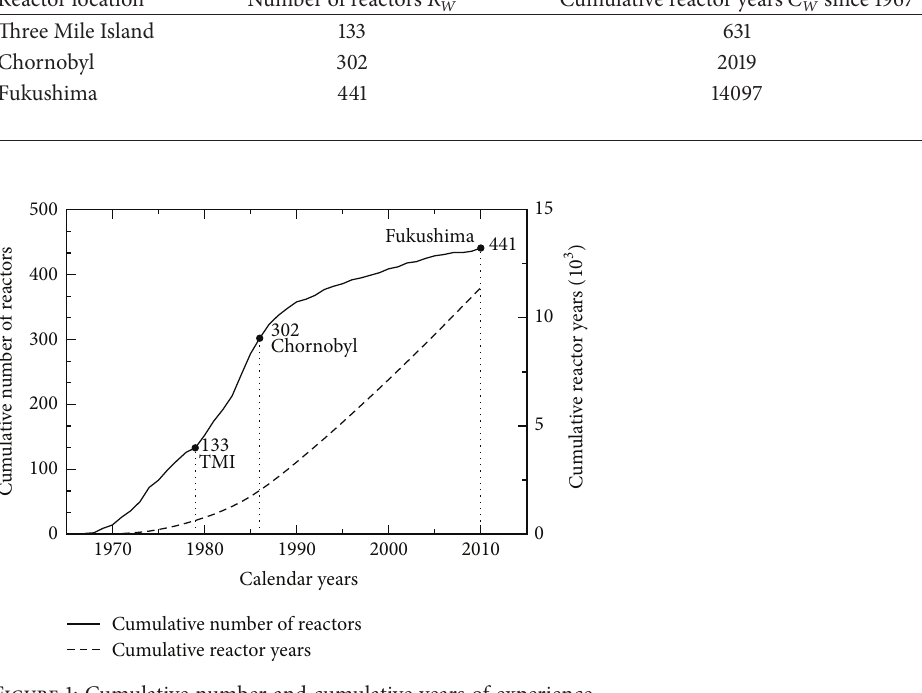
Figure 1: Cumulative number and cumulative years of experience for reactors connected to the grid until the end of 2010; reactor numbers in the years 1979, 1986, and 2011 with accidents of INES levels ≥ 5 are